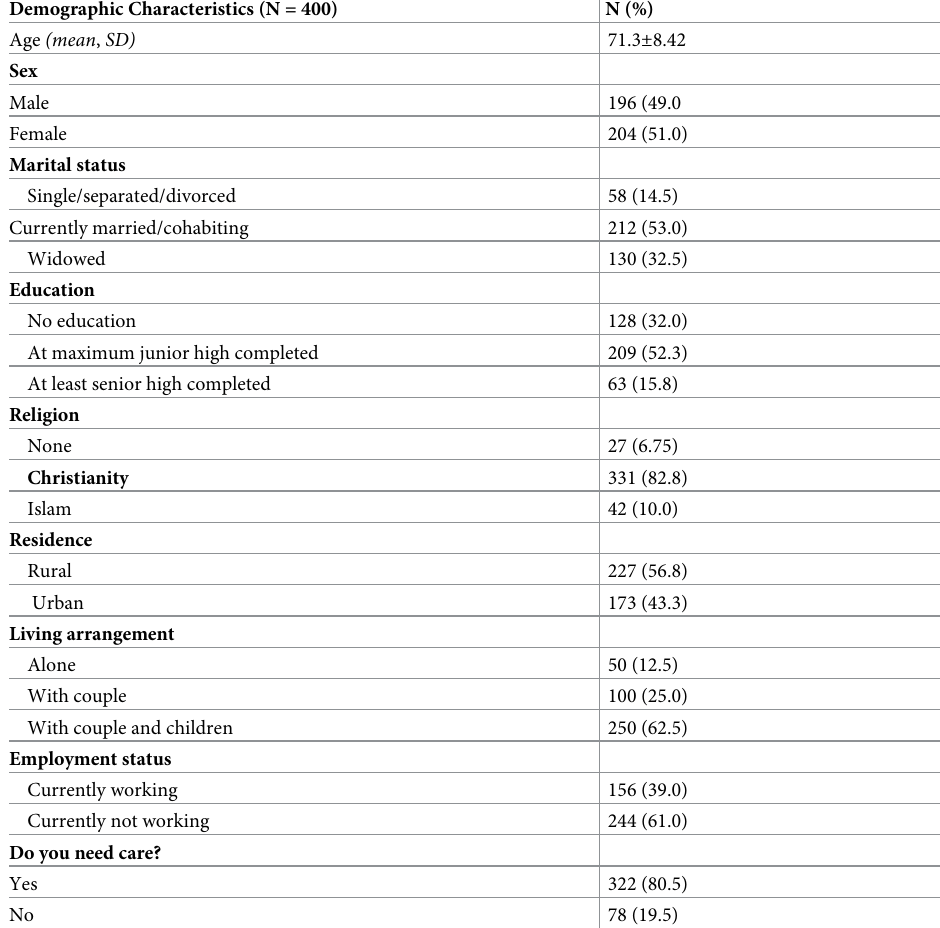
Table 1. Demographic characteristics of older people, and care